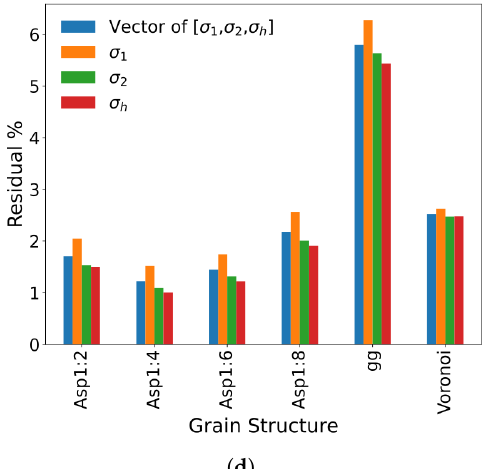
Figure 13. Overall predictive performance of the NN regression model. Prediction of ( a ) σ 1 , ( b ) σ 2 and ( c ) σ h based on the input of all the data to the trained and tested model. Note that in these plots representing the overall performance, the stresses have been converted back to the original scale, i.e., the one used as input for ML. ( d ) Residual % of NN model across various grain